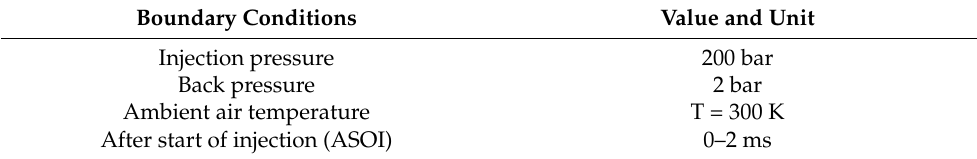
Table 1. Boundary conditions for operation.